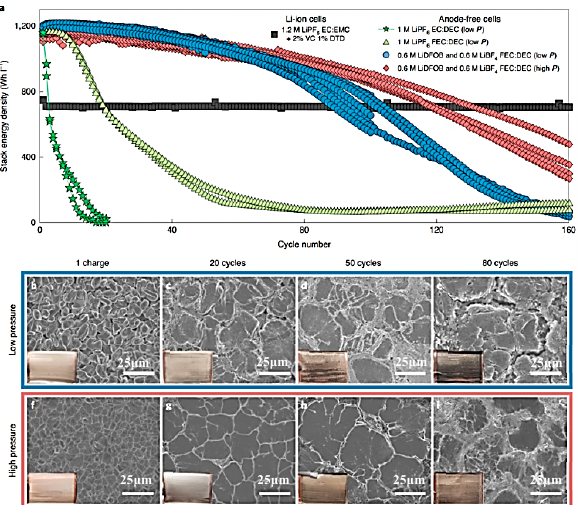
Figure 7. Comparison of anode-free and Li-ion cells with different electrolytes. Figure 7. ( a ) Comparison of anode-free and Li-ion cells with different electrolytes. ( b – i ) SEM images ( b – i ) SEM images of plated lithium at different pressure after different charging of plated lithium at different pressure after different charging cycles. Scale bars 25 µ m cycles. Scale bars 25 μ m [75].